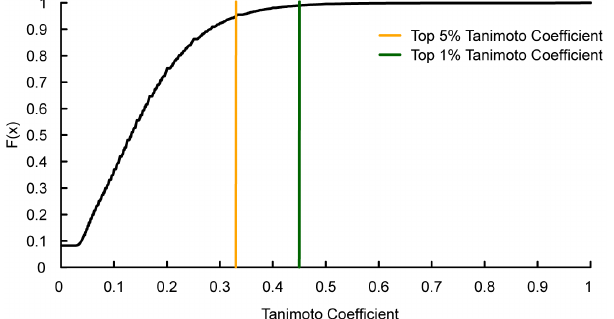
Figure 1. Cumulative frequency (F( x )) of pairwise Tanimoto coefficients for 1309